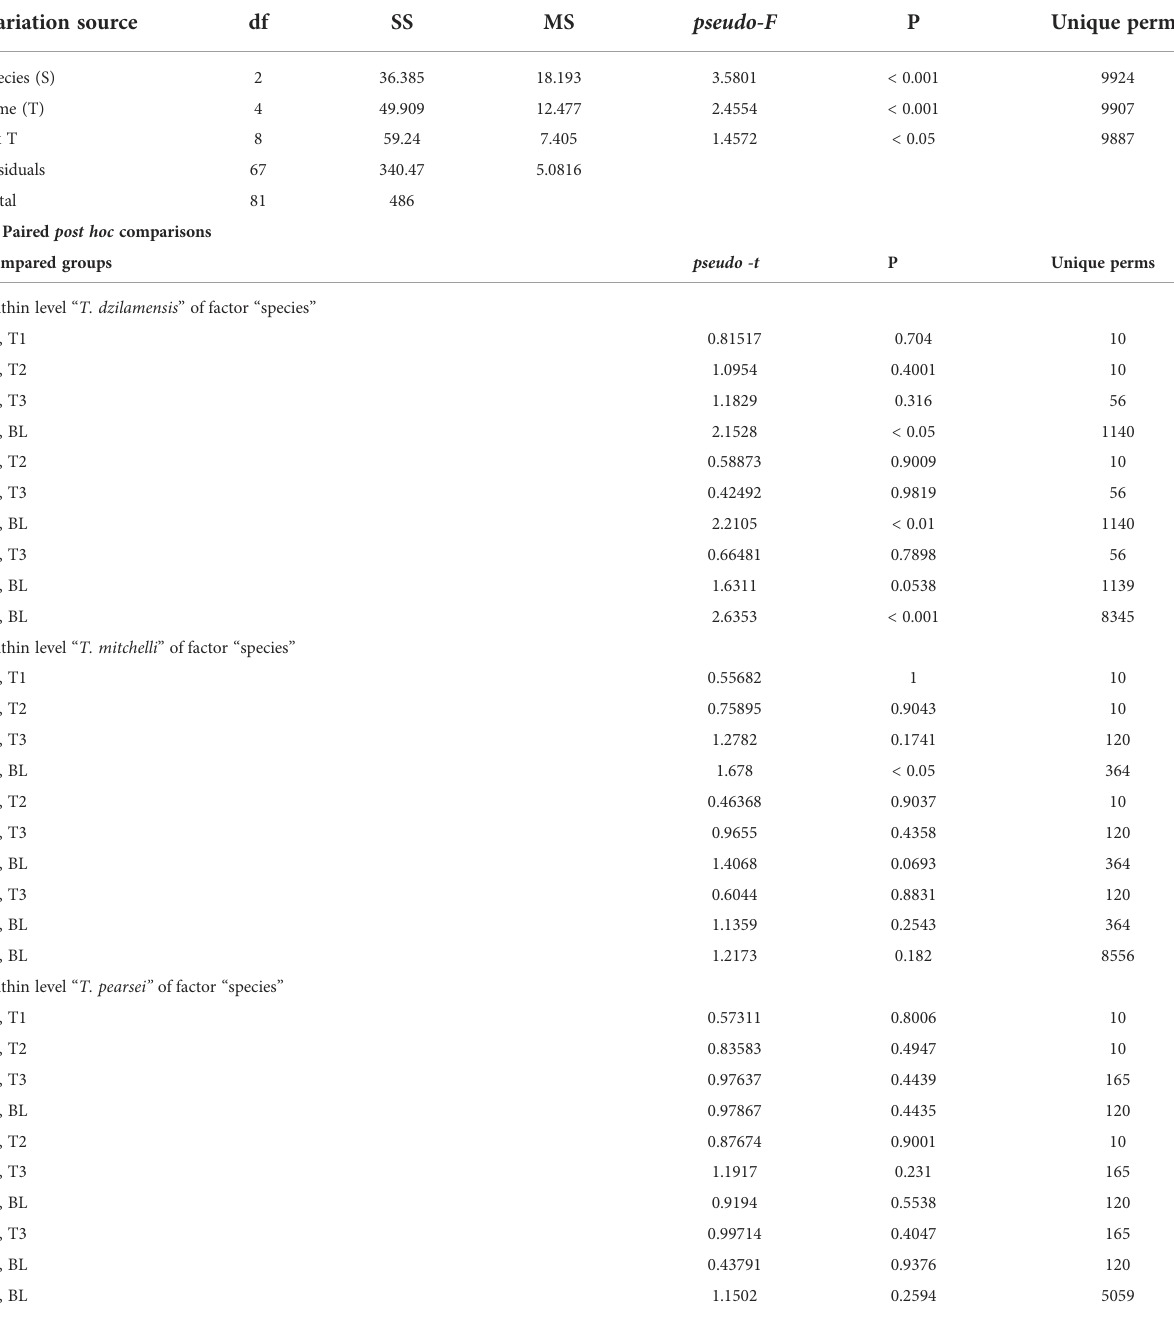
TABLE 1 Results of the permutational MANOVA on the biochemical indicators of individuals of T. mitchelli , T. pearsei and T. dzilamensis subjected to fi ve minutes of exercise and sampled at four time intervals: 0 (immediately), 30, 60 and 120 minutes after physical activity (T0 – T3 respectively), which were compared to baseline individuals